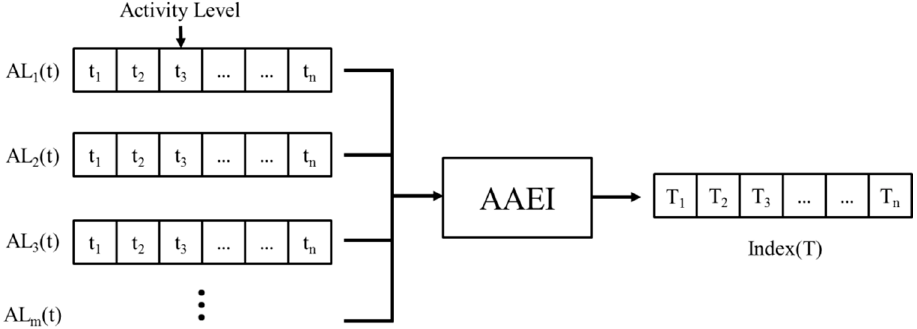
Figure 5. An accumulated activity effective index is estimated based on the time sequence activity